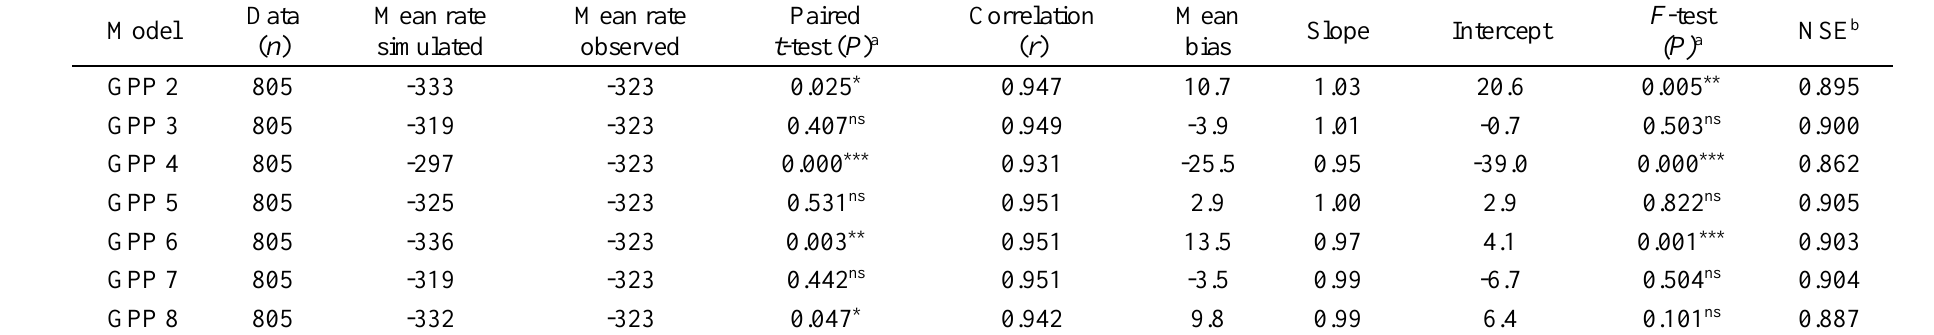
Table A5. Model performance statistics for gross primary production (GPP) models fitted to data from semi-flooded (S-F) treatments. Model